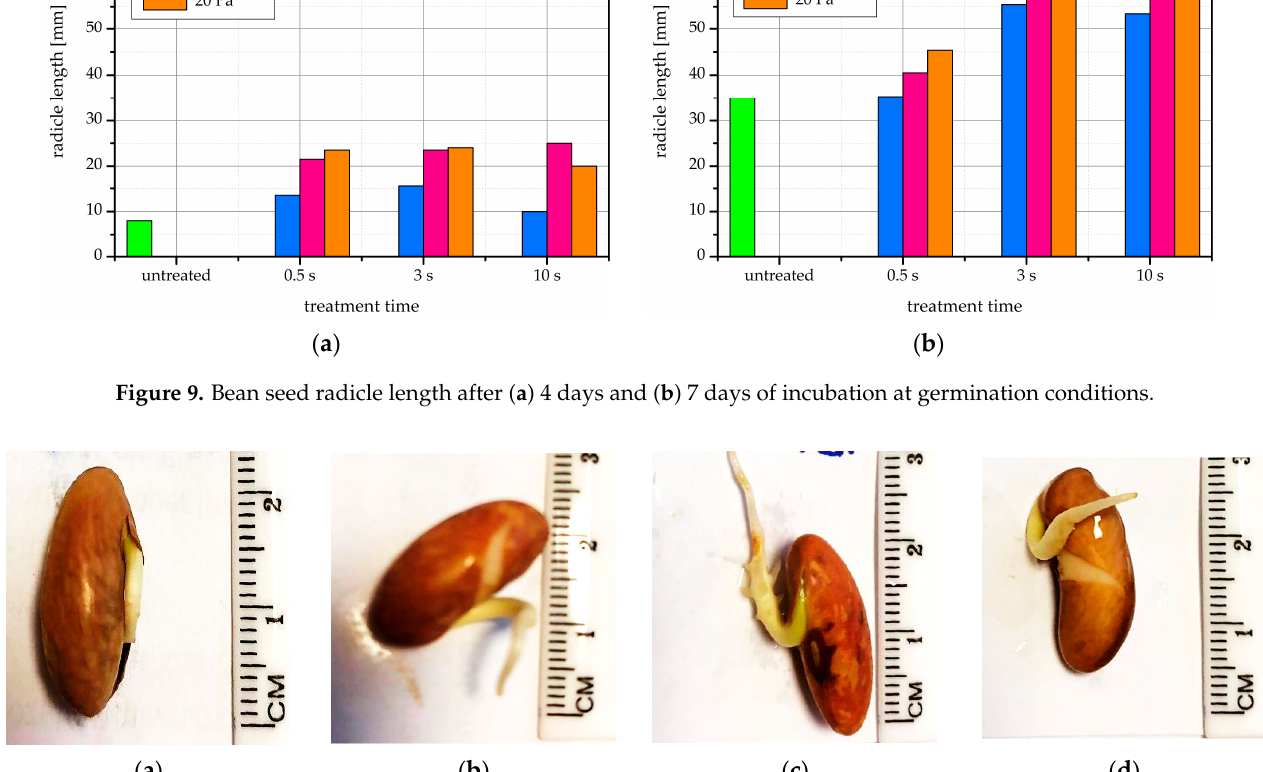
Figure 10. Visual comparison of bean seed radicle length after 4 days of incubation at germination conditions: ( a ) untreated; ( b ) p = 5 Pa, t = 10 s; ( c ) p = 15 Pa, t = 10 s; ( d ) p = 20 Pa, t = 10 s.